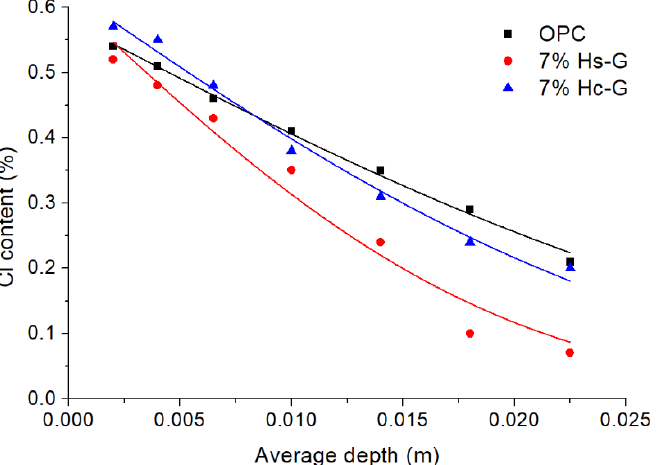
Figure 6. Chloride ion concentration with depth (experimental data fitted to Equation (2).